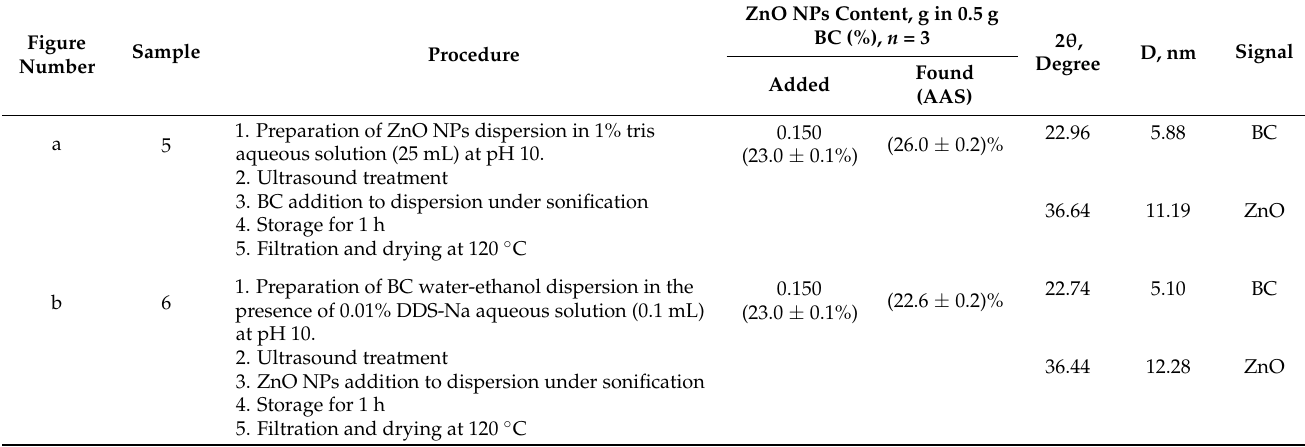
Table 3. The dependence of the structure of BC-ZnO NPs composition (23% of ZnO) on formation conditions (Figure